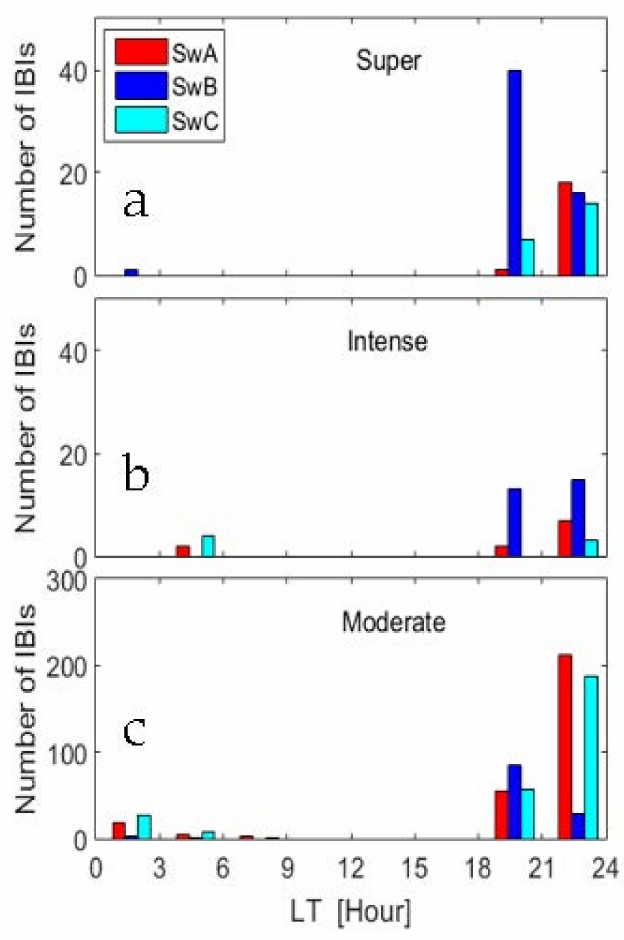
Figure 5. The number of IBIs with respect to local time during ( a ) super, ( b ) intense, and ( c ) moderate geomagnetic storms. Red, blue, and cyan colors correspond to IBIs observed by Swarm A, B, and C satellites,